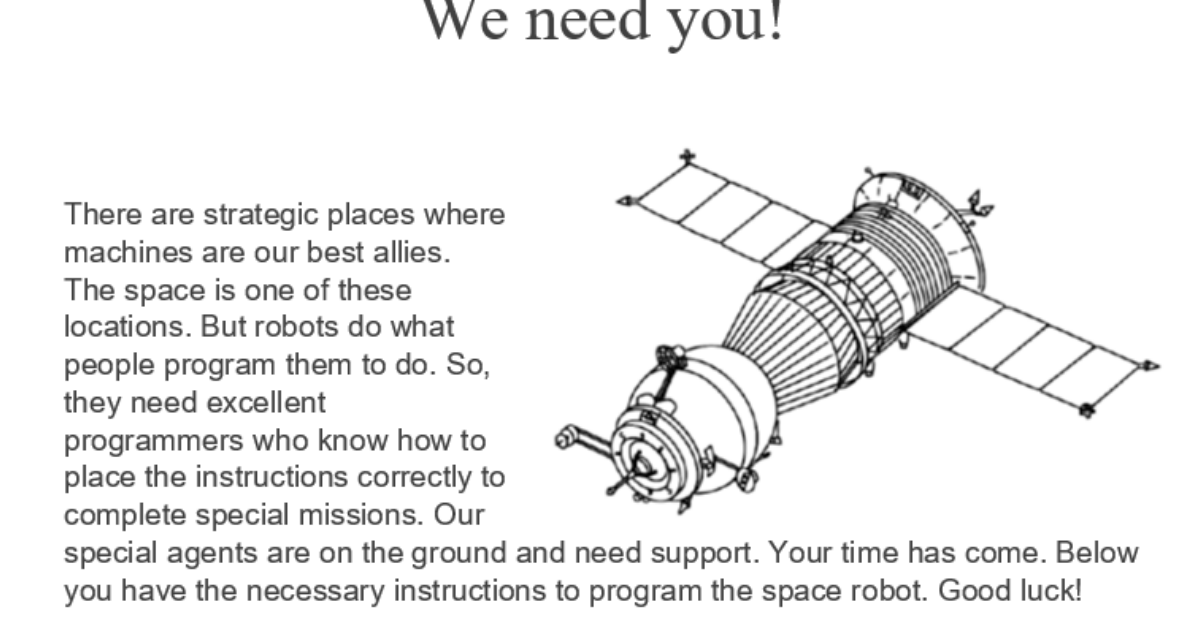
Figure 1. The introduction to the imaginary spatial robot activity.